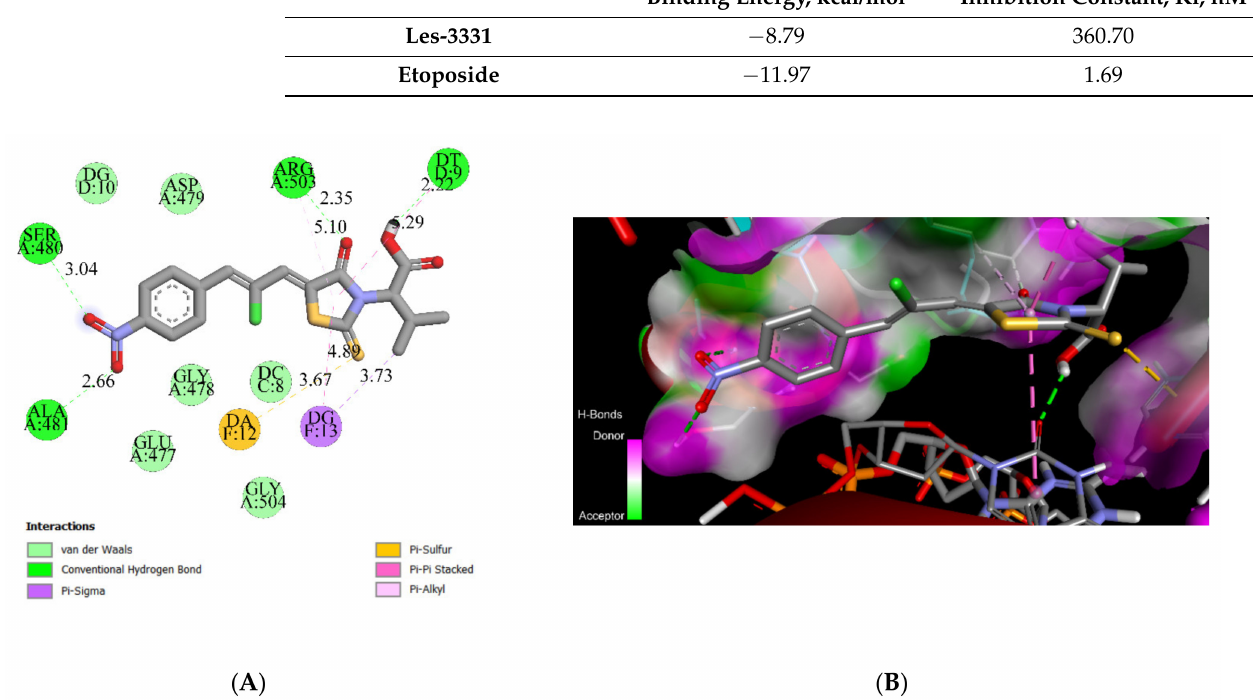
Figure 13. 2D ( A ) and 3D ( B ) schemes of the Les-3331–Topoisomerase II complex. Interaction with topoisomerase II possibly contributes to the summary potency of Les-3331 anti-breast cancer